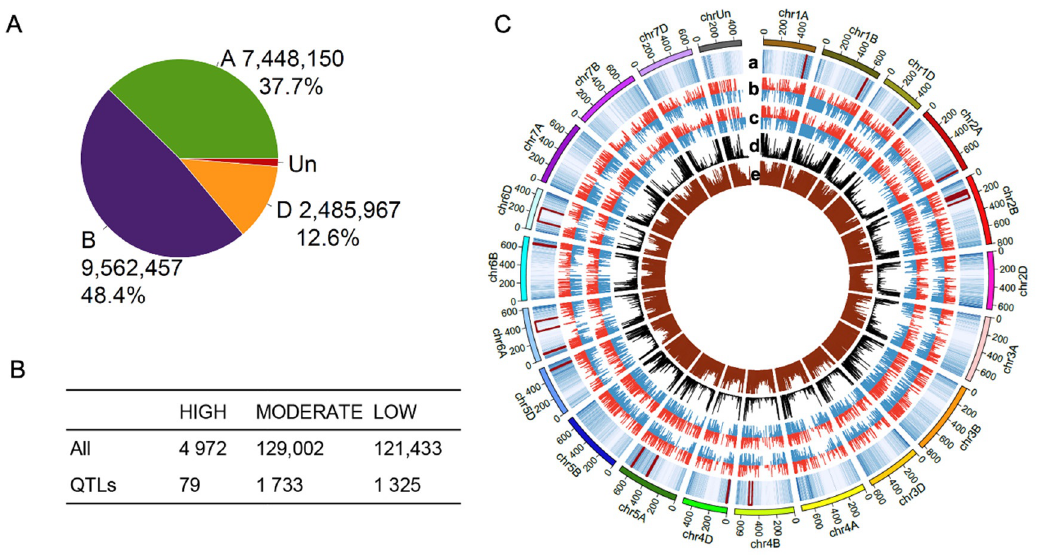
Figure 1. Whole-genome re-sequencing of the LM14 and HX10 cultivars. ( A ) The single nucleotide polymorphism (SNP) and insertion/deletion (InDel) variations identified by re-sequencing in A-, B-, D-subgenomes and unassembled chromosomal fragments of the two wheat cultivars. ( B ) The SNP and InDel variations on coding sequence (CDS) regions of the genes with high, moderate, and low effects localized on all the chromosomes or the 20 QTL regions. ( C ) The chromosomal distributions of the re-sequencing and RNA-sequencing datasets. The circles from outside to inside show (a) density of annotated genes; (b) density of differentially expressed genes (DEGs) between the two cultivars at 6 h post abscisic acid (ABA) treatment and (c) at 24 h post ABA treatment; (d) density of SNP and InDel variations with high effects; and (e) moderate effects and total SNP/InDel density.